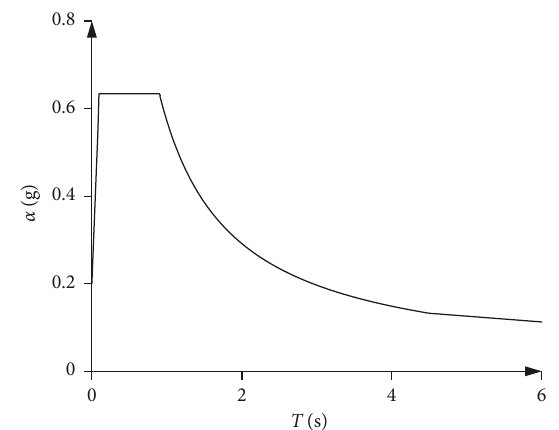
Figure 4: Seismic response spectrum